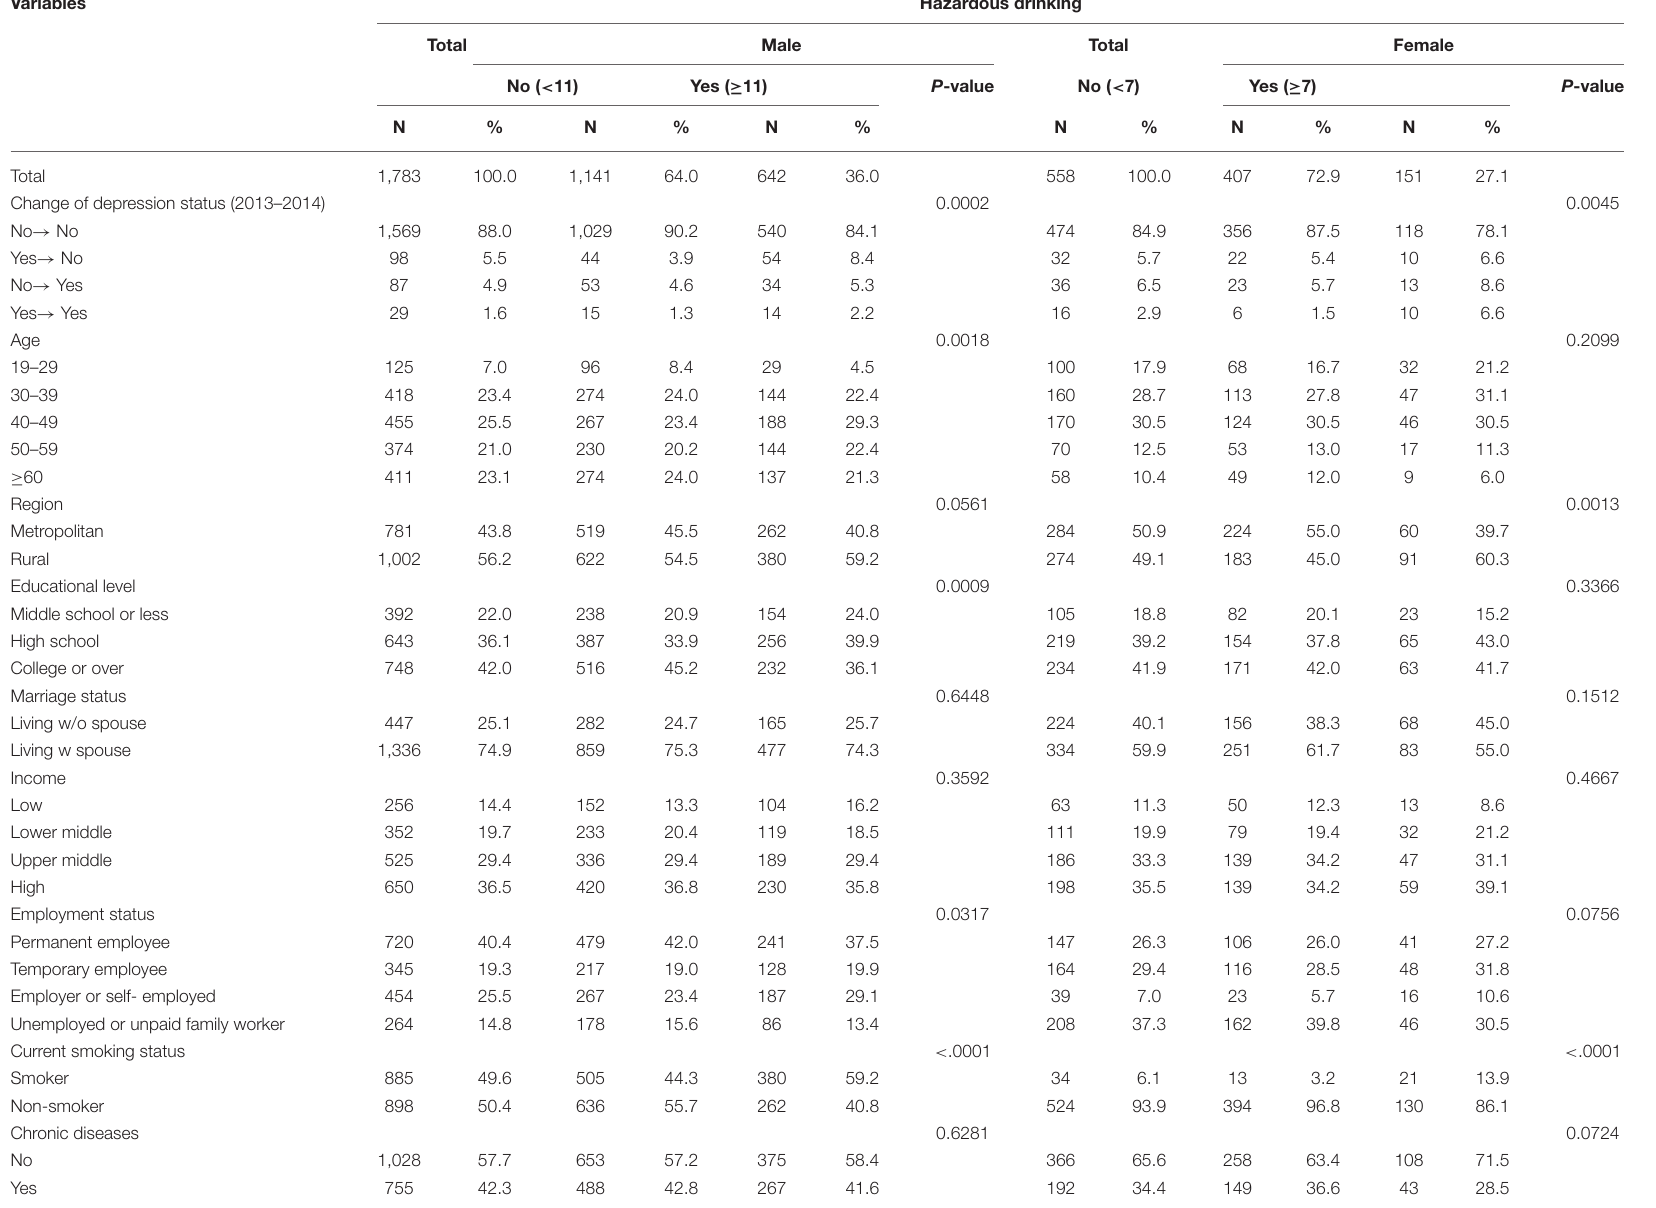
TABLE 1 | General characteristics of the study population at the first change time-point (2013 →